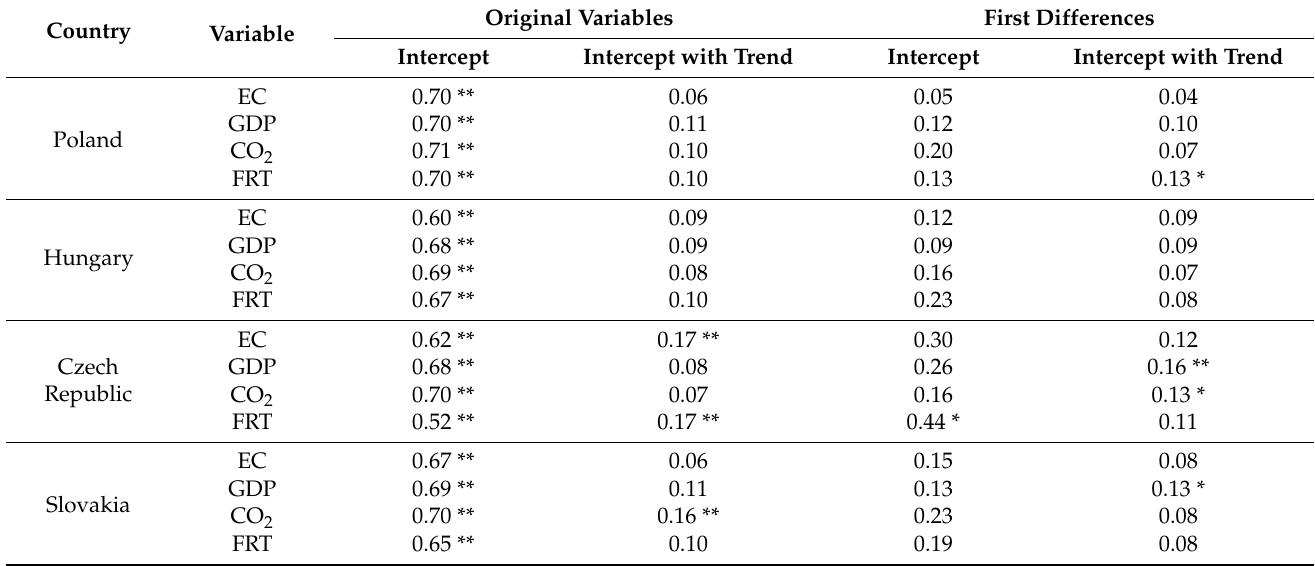
Table 4. Unit root test results